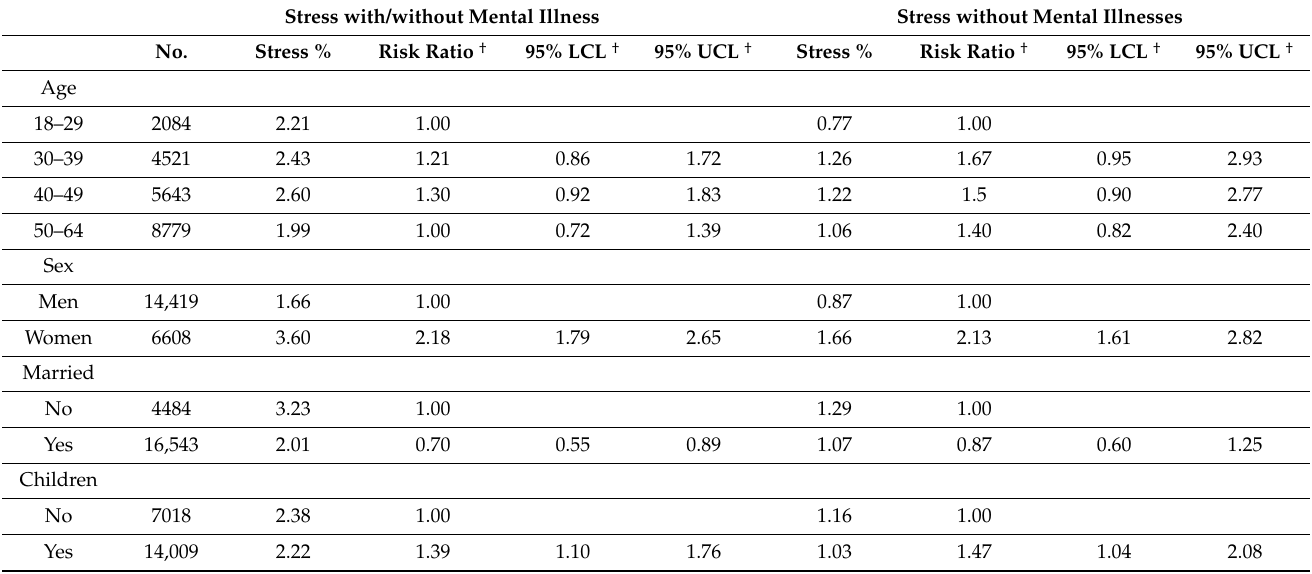
Table 1. Risk of Stress in Employees According to Selected Demographic Variables, 2020. Stress with/without Mental